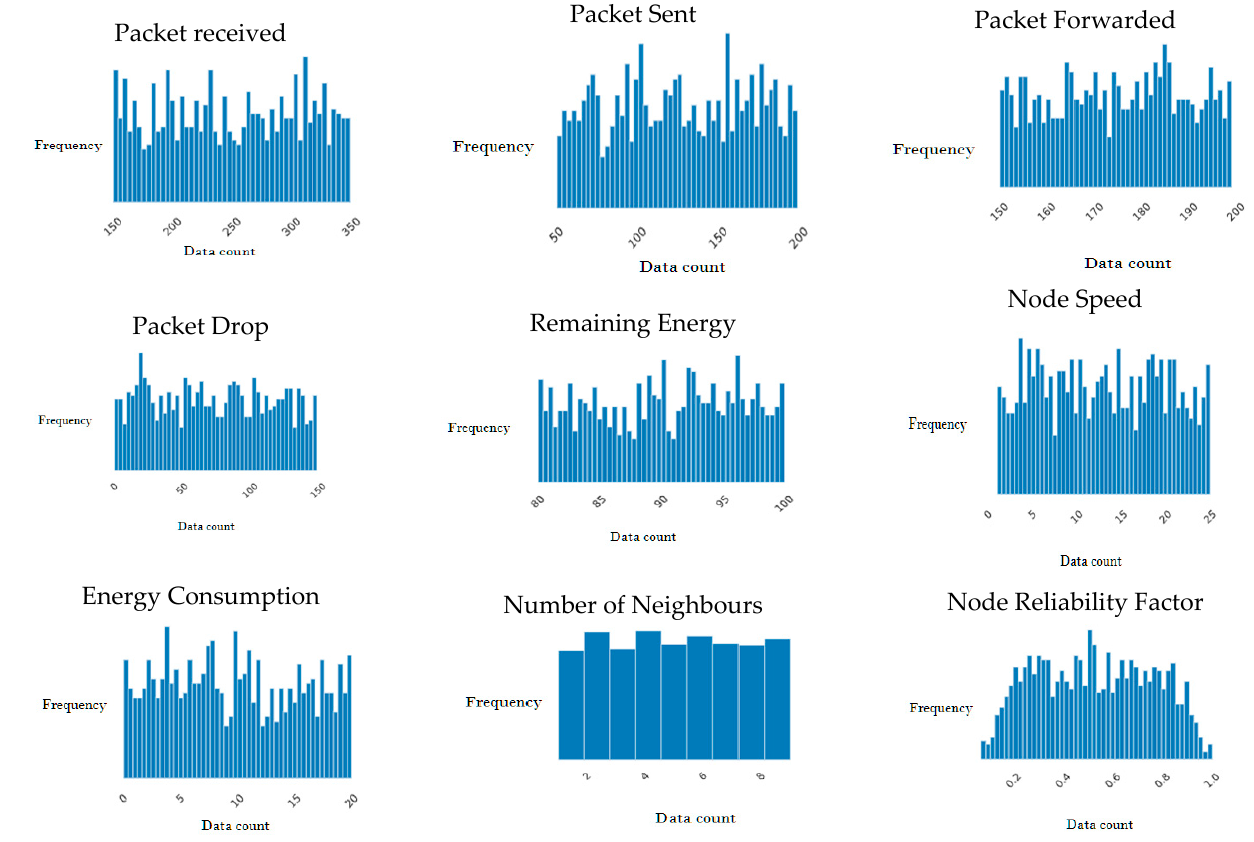
Figure 7. Histogram of features.